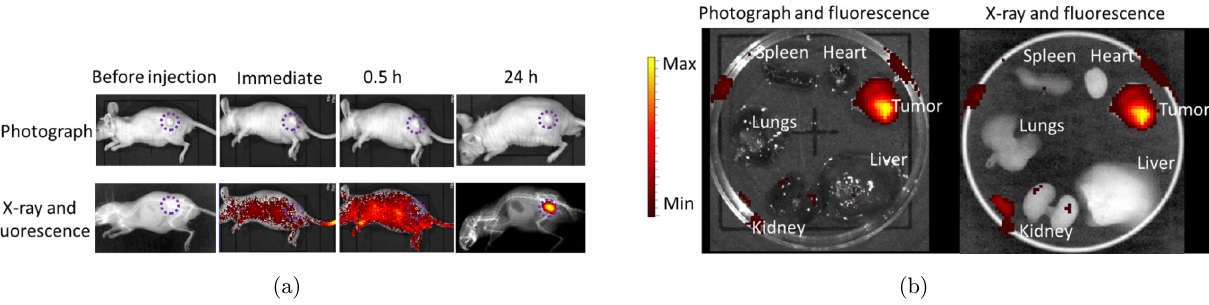
Fig. 5. (a) X-ray and °uorescence images of the tumored nude mouse at before injection and various time points post injection with LBPD (immediate, 0.5 h, and 24 h). Purple circles indicate the tumor tissue. (b) Photograph and °uorescence images of the major organs resected from mouse 24 h post injection.